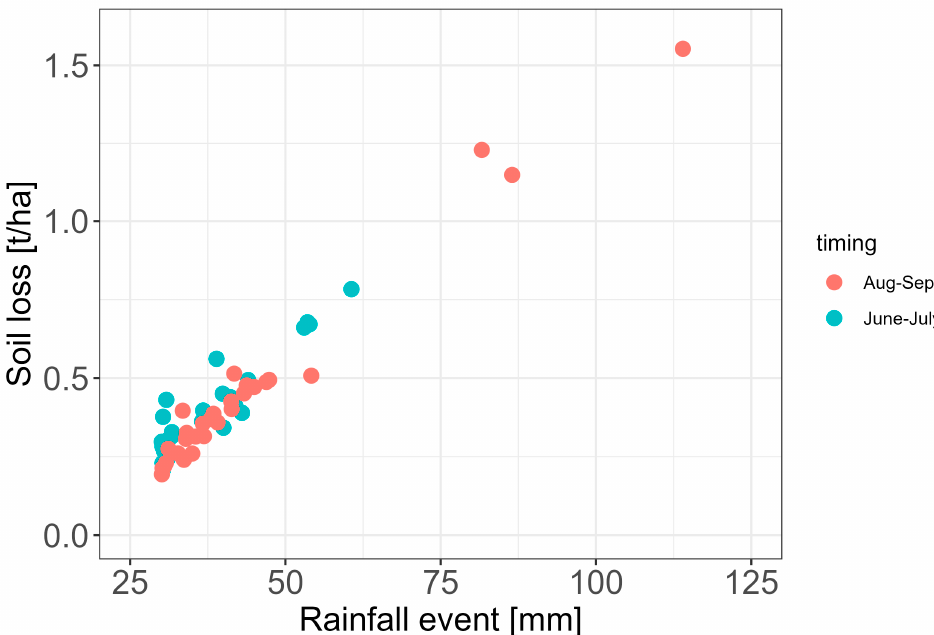
Figure 5. Effect of the timing of the rainfall event on soil loss rates in the Tougou watershed over the period 2010–2018. Rainfall events occurring at the onset of the rainy season (June–July) generate slightly higher soil loss rates than rainfall events occurring at the middle-end of the rainy season (August–September).